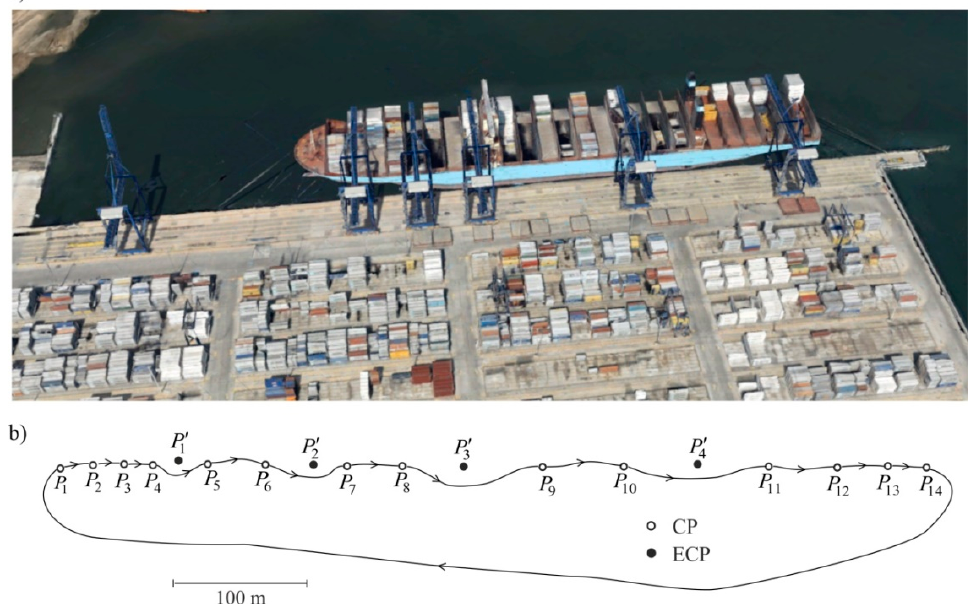
Figure 6. The course of controlled values of norms in individual iteration steps.